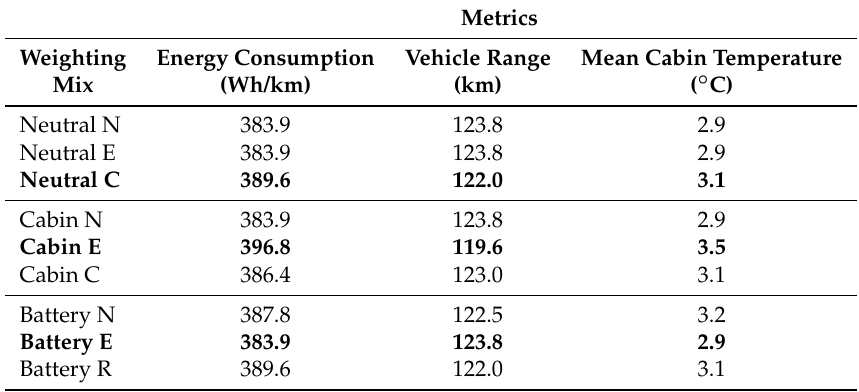
Table 9. Vehicle metrics corresponding to solutions from sensitivity testing performed at − 15 ◦ C. Here bold text indicates the most preferable outcome in the authors